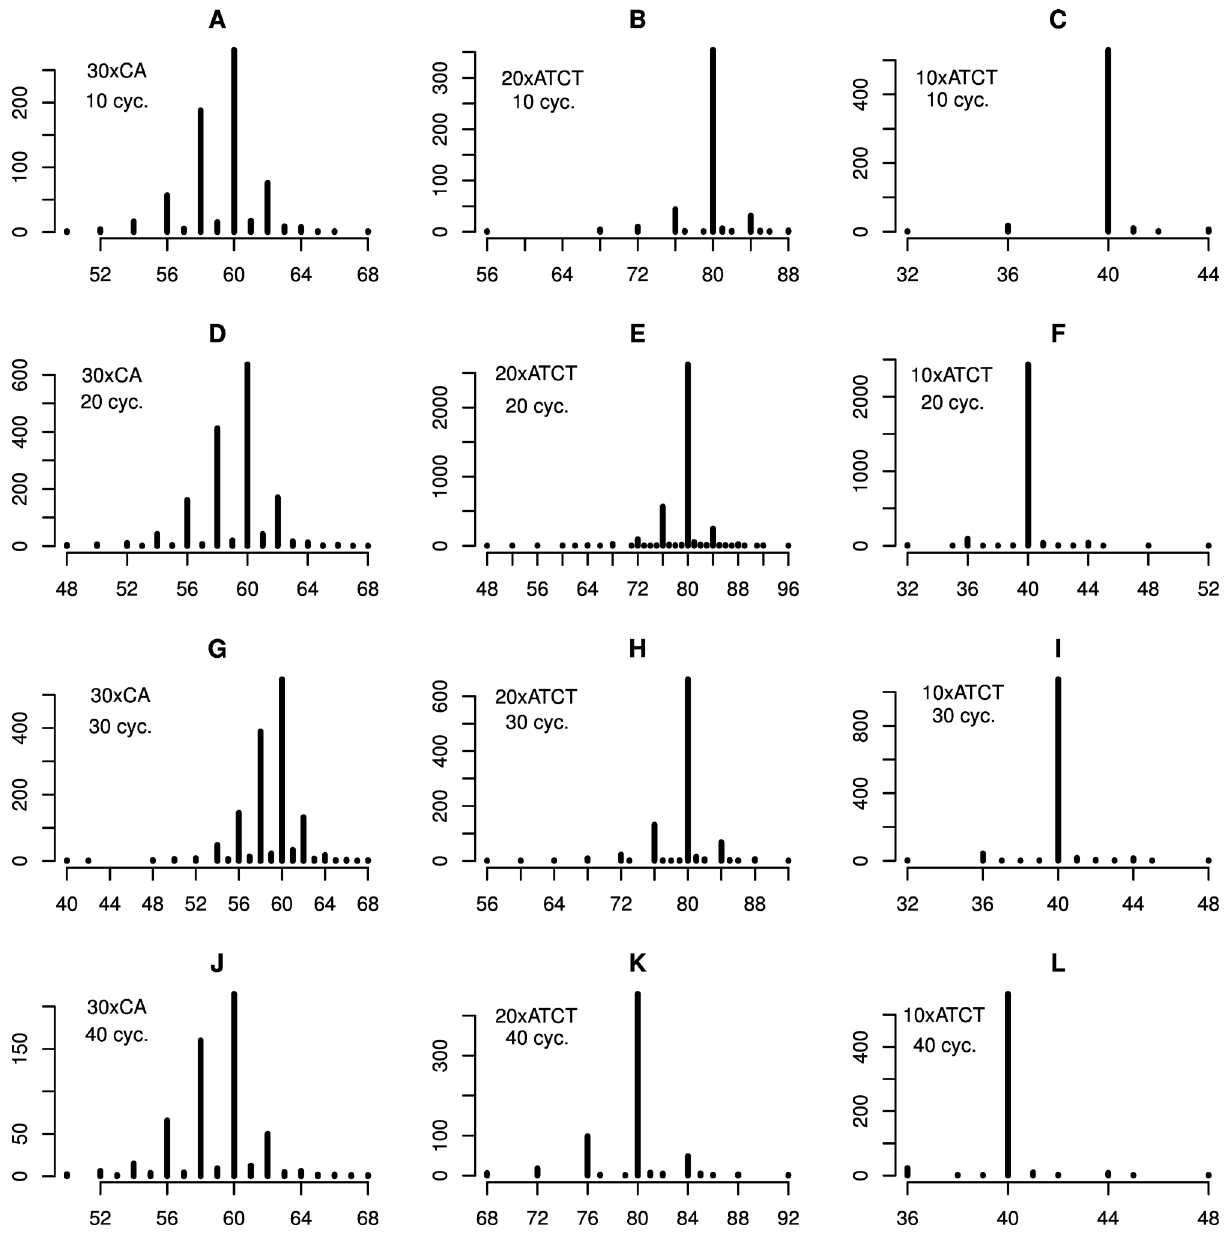
Fig 3. Mean microsatellite length distributions for PCR amplified fragments. A, D, G and J: 30xCA. B, E, H and K: 20xATCT. C, F, I and L: 10xATCT. A-C: 10 PCR cycles. D-F: 20 PCR cycles. G-I: 30 PCR cycles. J-L: 40 PCR cycles. All panels show mean results from two replicate PCR reactions. The y-axes indicate the number of SMRT sequence reads corresponding to the sequence length (bp) indicated on the x-axes. In each panel the target sequence length can be seen to dominate. Singleton read lengths have been omitted from the plots for enhanced visualization (see S5 – S8, S10 – S13, S15 – S18 and S20 – S23 Figs for full